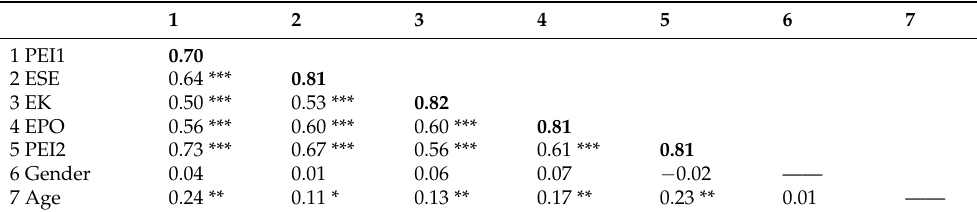
Table 3. Construct correlations.